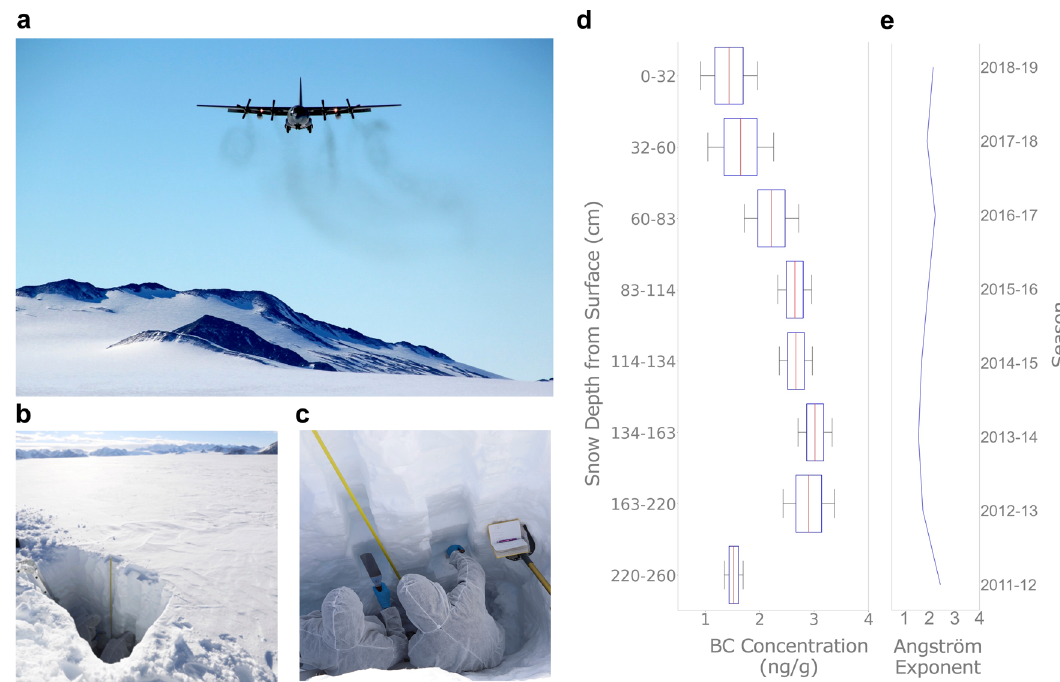
Fig. 3 Black Carbon (BC) concentration is above background levels even around deep- fi eld tourist destinations. a C-130 aircraft about to land on the blue-ice runway at Union Glacier (79°S, Ellsworth Mountains), an increasingly popular deep- fi eld destination (a private four-engine turbofan Ilyushin Il-76 landed on the runway 30 times in the 2019 – 2020 season only 34 ). b , c Snowpit for snow sampling (6 km east of the blue-ice runway and about 1 km west of the designed landing sites for ski-equipped airplanes). d BC concentrations measured at different snow layers. BC concentration peaked at about 3 ng/g during the 2013 – 2014 season. Although private activities began years earlier, the Chilean Union Glacier Camp became operational during the 2013 – 2014 season. In each box, the central mark (red stripe) indicates the median, and the edges indicate the 25th and 75th percentiles. The whiskers extend to the maximum and minimum data excluding outliers. e Mean of the absorption Ångström exponent of light-absorbing impurities in snow from different layers. Photographs taken by the authors. Plots were generated by using Python ’ s Matplotlib Library 58 .